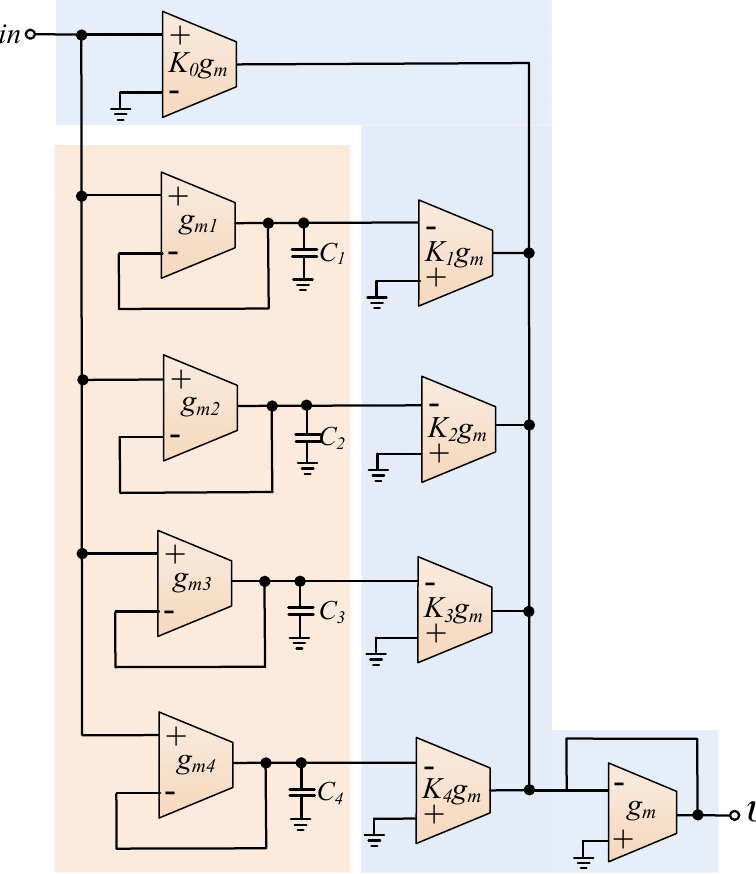
Figure 4. OTA-C implementation of the approximated compensator.